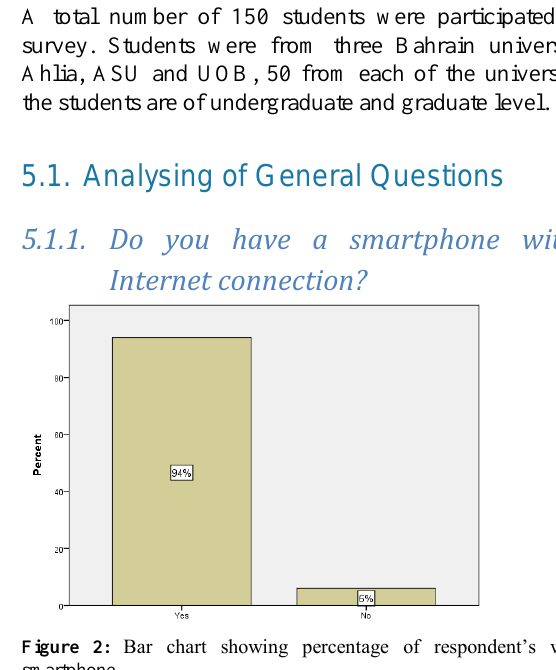
EAI Endorsed Transactions